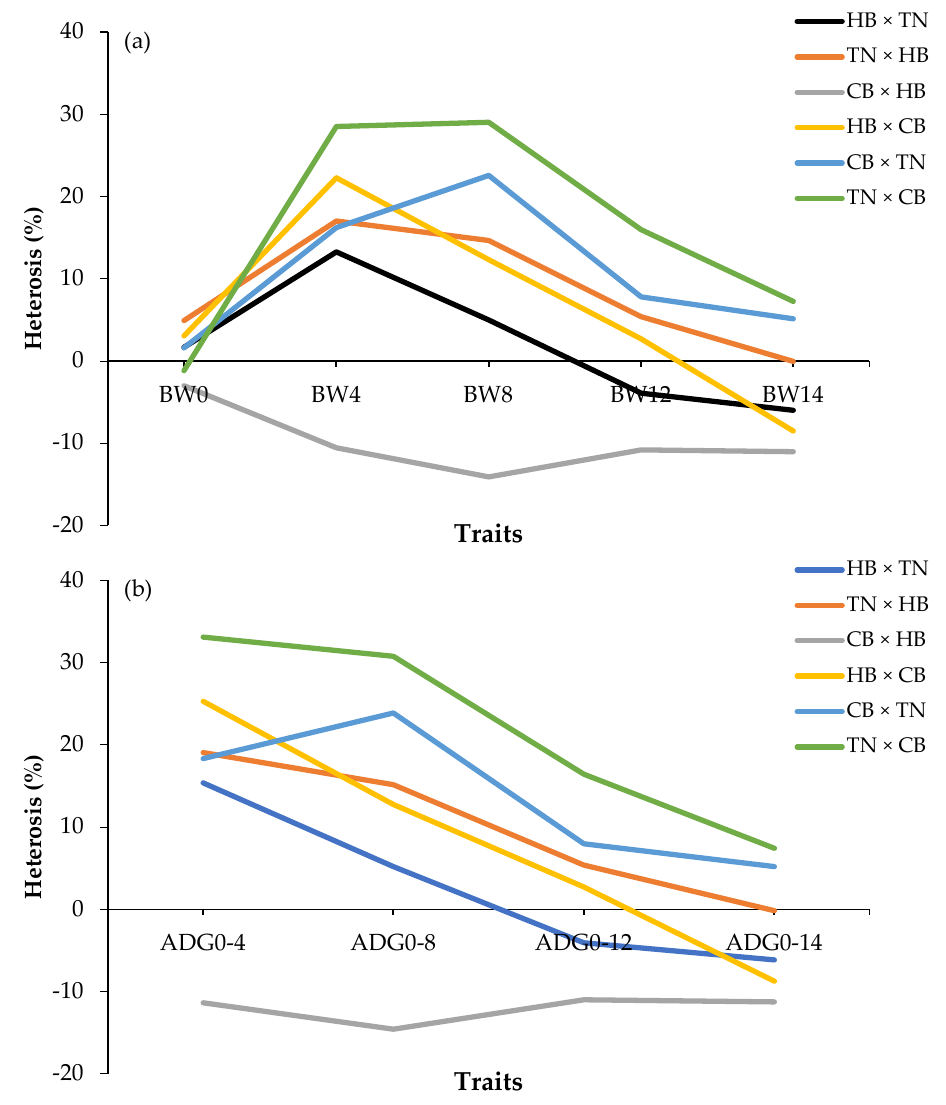
Figure 3. Percentage of heterosis of body weight ( a ); average daily gain ( b ); HB × TN — crossbred chicken between Hmong black-bone chicken (used as chicken cocks) and Thai native chicken (used as chicken hens) (black bar); TN × HB — crossbred chicken between Thai native chicken (used as chicken cocks) and Hmong black-bone chicken (used as chicken hens) (orange bar); CB × HB — crossbred chicken between Chinese black-bone chicken (used as chicken cocks) and Hmong black-bone chicken (used as chicken hens) (gray bar); HB × CB — crossbred chicken between Hmong black-bone chicken (used as chicken cocks) and Chinese black-bone chicken (used as chicken hens) (yellow bar); CB × TN — crossbred chicken between Chinese black-bone chicken (used as chicken cocks) and Thai native chicken (used as chicken hens) (blue bar); TN × CB — crossbred chicken between Thai native chicken (used as chicken cocks) and Chinese black-bone chicken (used as chicken hens) (green bar);